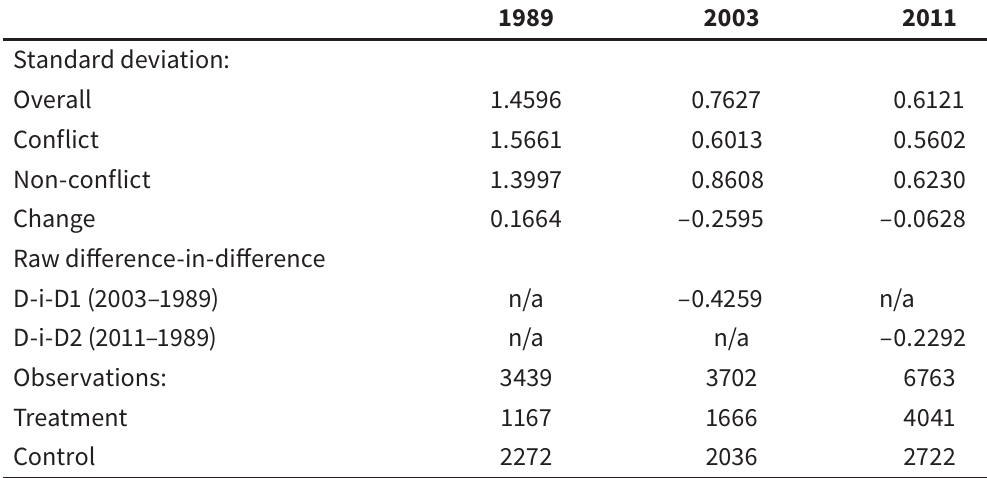
Standard Deviation of Log of Household Expenditure by Conflict Exposure